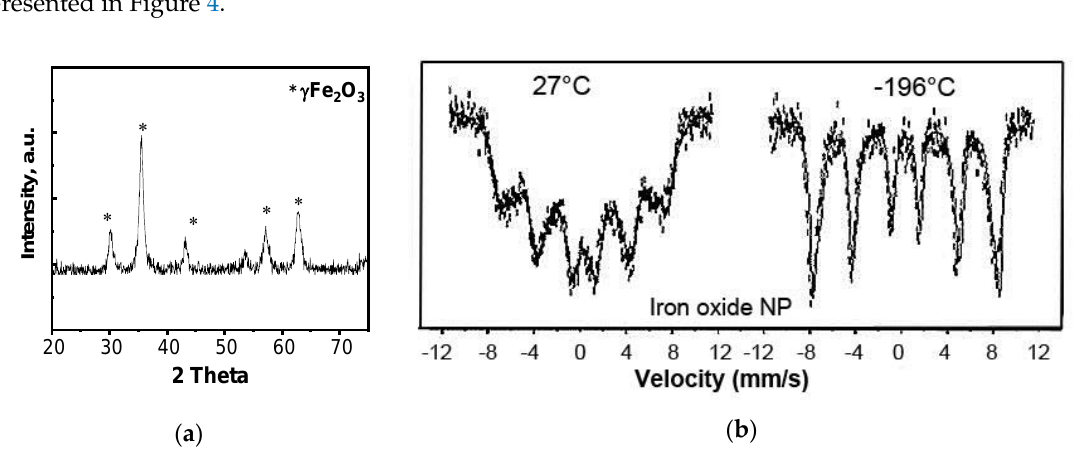
Figure 4. X-ray di ff raction pattern ( a ) and Mössbauer spectra ( b ) of the Figure 4. X-ray diffraction pattern ( a ) and Mössbauer spectra ( b ) of the MNPs.